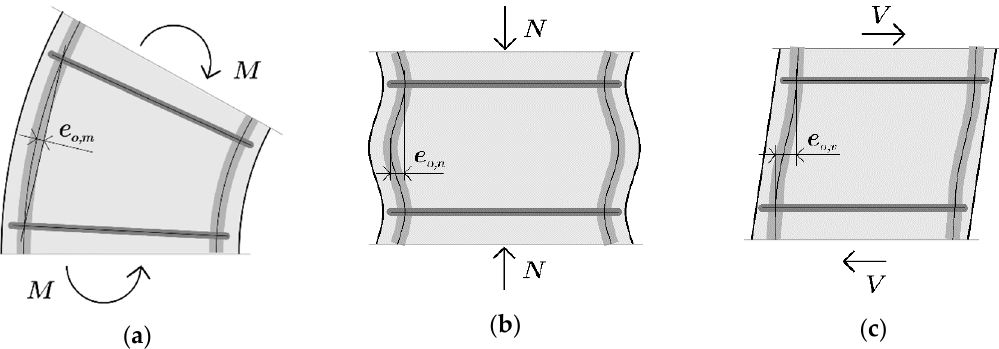
Figure 2. Deformation of rebar due to: ( a ) bending moment (MD), ( b ) compression force (ND) and ( c ) shear force (VD).